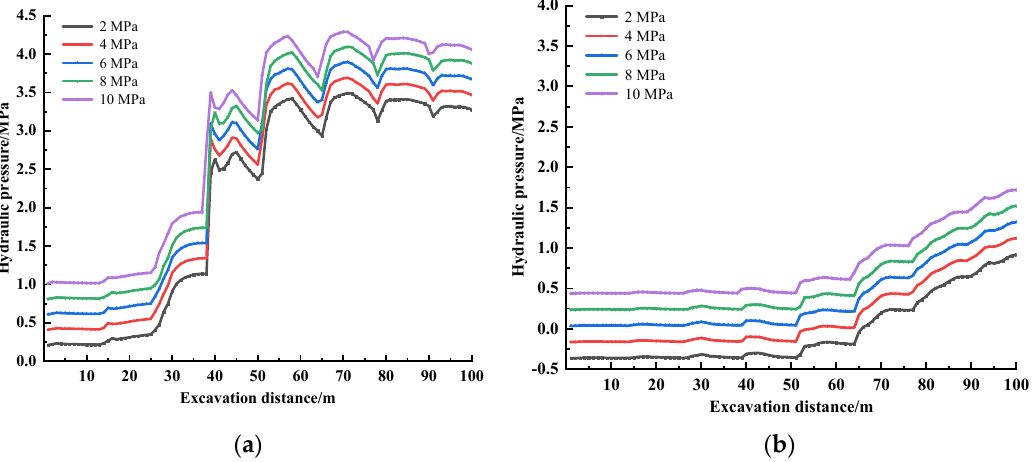
Figure 10. Water pressure variation curves at different monitoring points. ( a ) Monitoring point A, ( b ) monitoring point B.